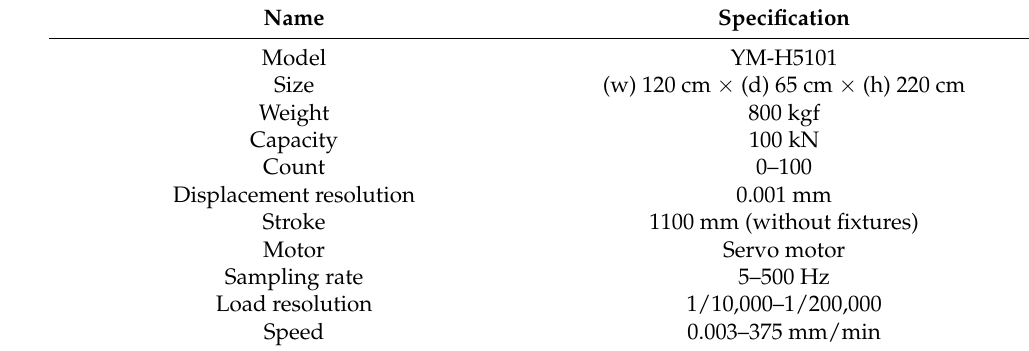
Table 4. The specifications of the YM-H5101 universal testing machine.